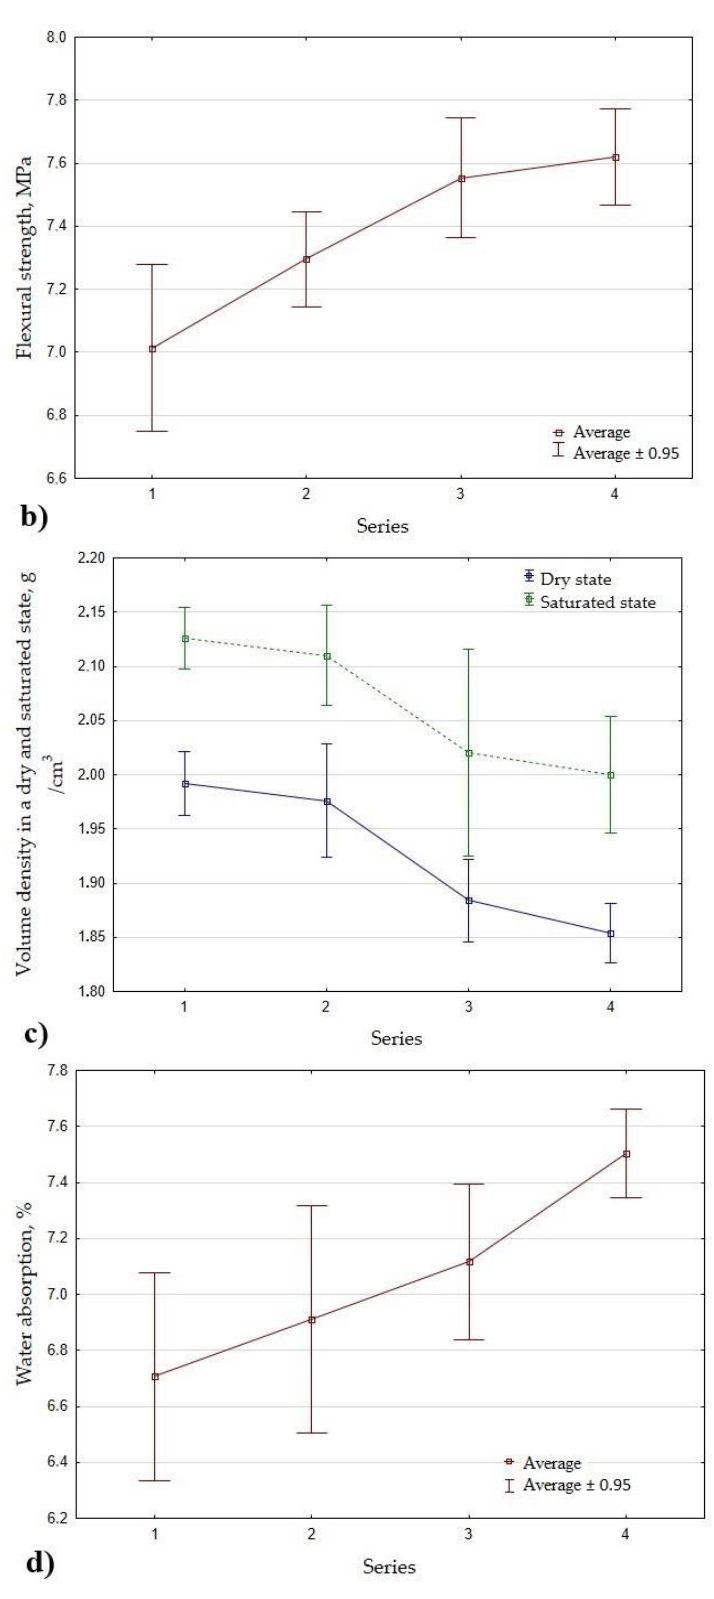
Figure 8. The average test results of geopolymer mortar containing recycled fines: ( a ) compressive strength after 28 days; ( b ) flexural strength after 28 days; ( c ) volume density in dry and saturated states; ( d ) the water absorption.